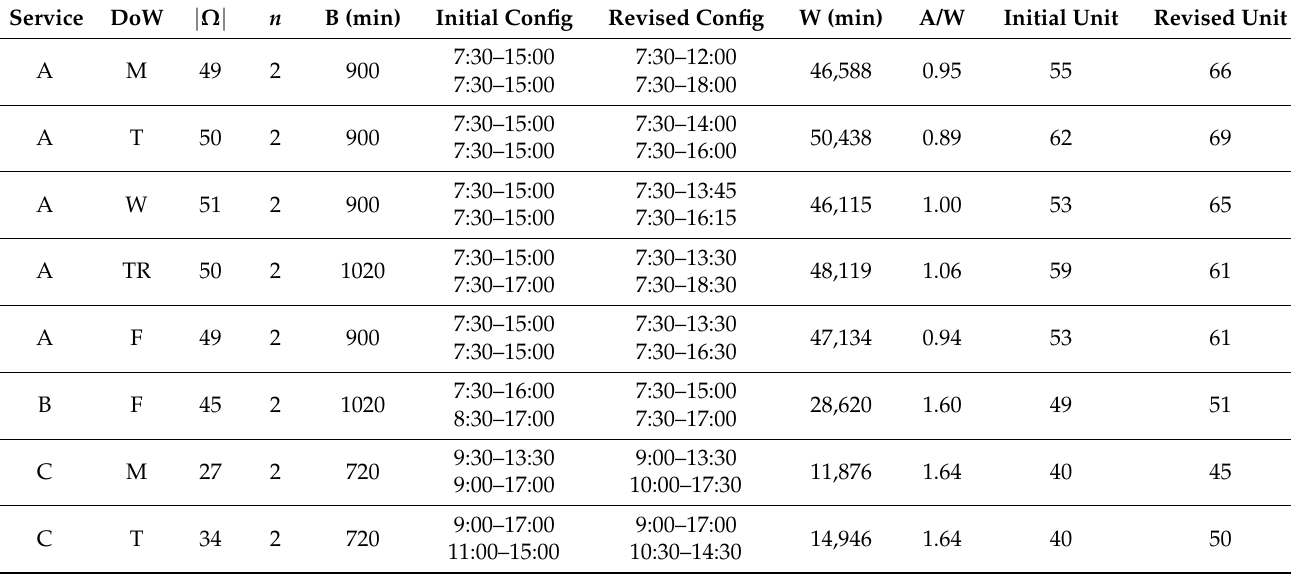
Table 2. Optimizing block configuration—an